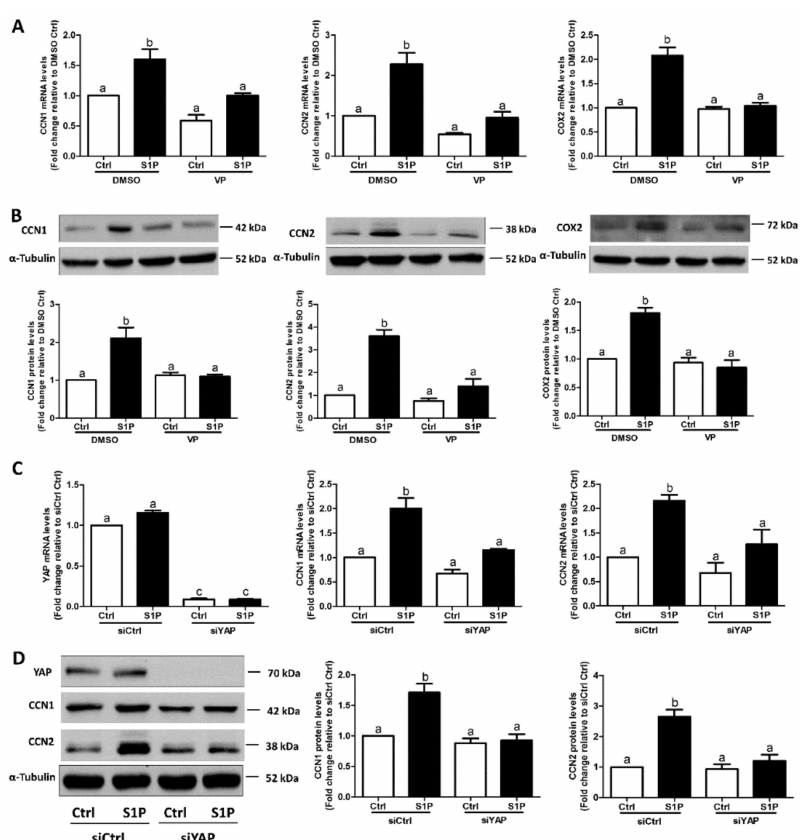
Figure 6. YAP mediates the S1P-induced upregulation of CCN1, CCN2, and COX2 expression in SVOG cells. SVOG cells were pretreated with a vehicle control (DMSO) or 10 µ M verteporfin (VP, a YAP-specific inhibitor) for 1 h and then treated with a vehicle control or 0.3 µ M S1P for 1 h ( A ) or 2 h ( B ). The mRNA ( A ) and protein ( B ) levels of CCN1, CCN2, and COX2 were examined using RT-qPCR ( A ) and western blot analysis ( B ), respectively. SVOG cells were transfected with 50 nM siCtrl or 50 nM YAP siRNA (siYAP) for 48 h. followed by treatment with a vehicle control or 0.3 µ M S1P for 1 h ( C ) or 2 h ( D ). The mRNA ( C ) and protein ( D ) levels of YAP, CCN1 and CCN2 were examined using RT-qPCR ( C ) and western blot analysis ( D ), respectively. The results are presented as the mean ± SEM of at least three independent experiments. Values marked by di ff erent letters were significantly di ff erent ( p <